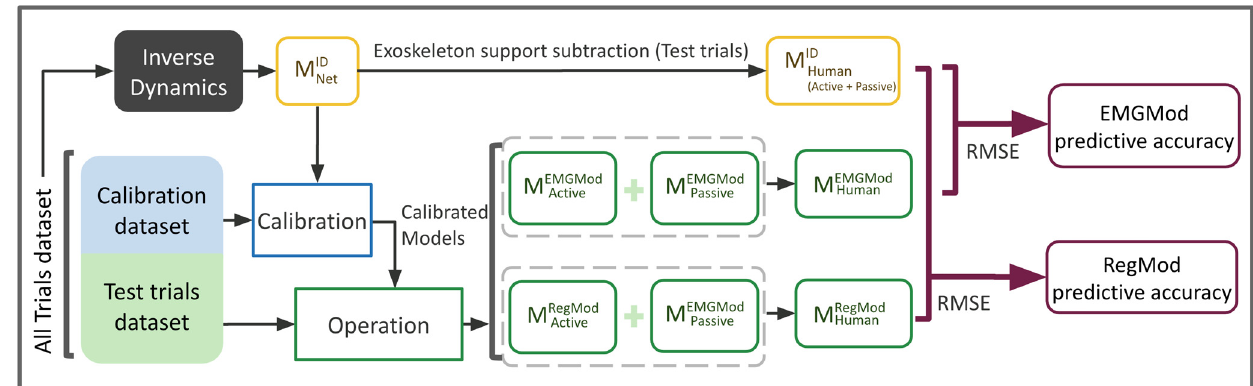
Figure 4. Data processing and evaluation pipeline for a calibration set. Inverse dynamics (ID) was implemented to determine the moment around the lumbar spine (M Human ) for all trials. Next, the dataset collected during a set of calibration trials was used to calibrate the EMG-driven muscle model (EMGMod) and the regression model (RegMod), successively. Calibrated models were used to predict the active M Human during a set of test trials. To evaluate the predictive accuracy achieved by the calibration set, the total M Human , determined by ID, was compared with that predicted by the EMGMod and that predicted by the RegMod.